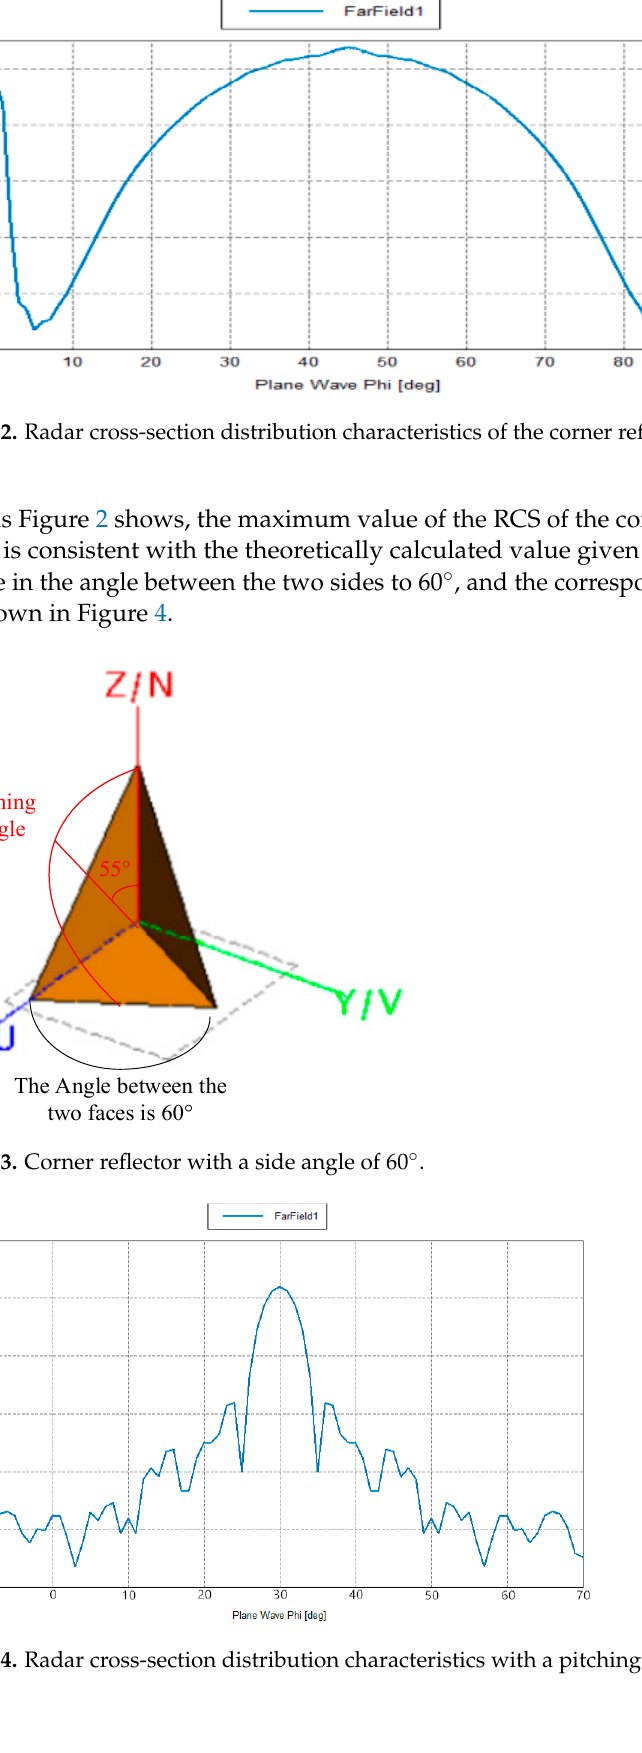
Figure 4. Radar cross-section distribution characteristics with a pitching angle of 55°.